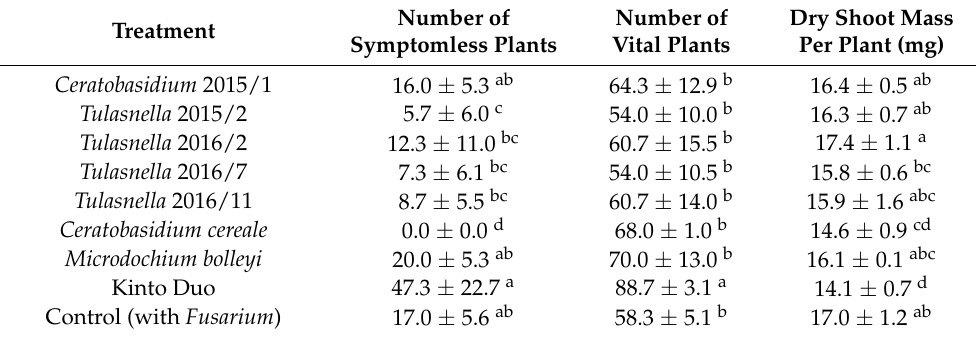
Table 4. Significant evaluated parameters of Experiment 2 include number of symptomless (no observable impact of Fusarium culmorum ) plants emerged from 100 grains contaminated with F. cul- morum (tribe KM16902) sown, number of vital plants (lacking any symptoms of necrosis or chlorosis caused by F. culmorum ), and dry shoot mass per emerged plant (mg). Data represent means ± SD ( n = 3) followed by the same letter (within the column) if there was no statistical difference according to LSD 0.05 test. Number of Number of Dry Shoot Mass Treatment Symptomless Plants Vital Plants Per Plant (mg) Ceratobasidium